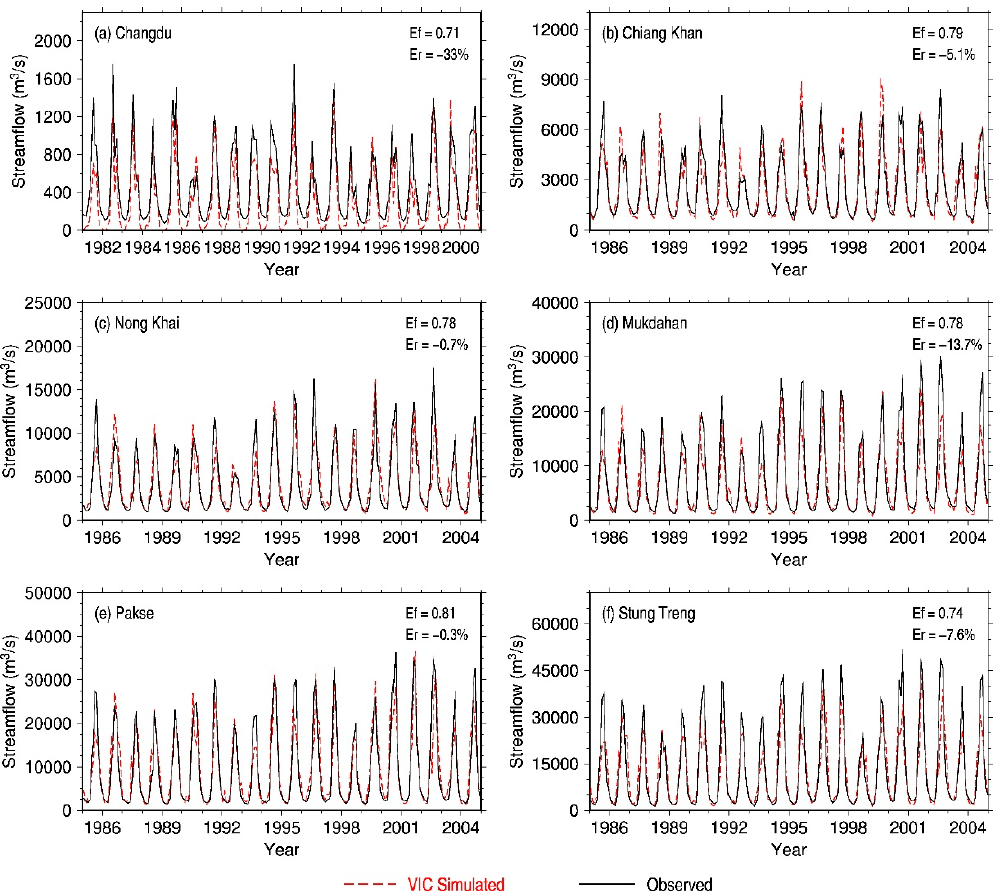
Figure 5. Comparisons of monthly streamflow between VIC simulations and observations at six hydrological gauging stations for the 20-year calibration period. ( a ) Changdu; ( b ) Chiangkhan; ( c ) NongKhai; ( d ) Mudahan; ( e ) Parkse; ( f ) StungTreng.